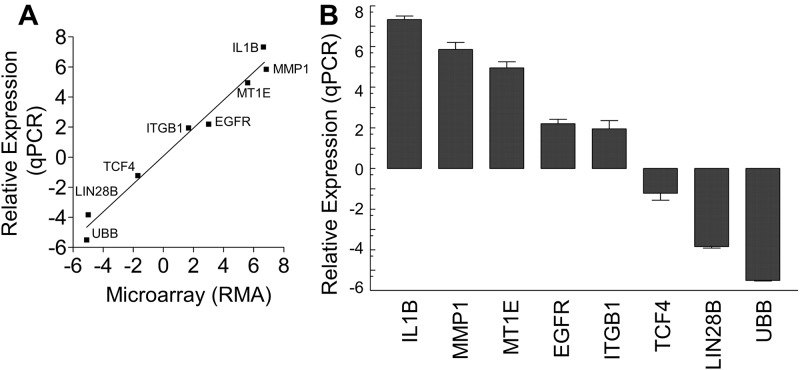
Differentially expressed transcripts between OVCAR-8R and OVCAR-8 spheroids are correlated between microarray and qPCR assays.Genes in the microarray dataset with differences in expression between sensitive and resistant ovarian cancer spheroids. (A) qPCR and microarray expression levels correlate. qPCR relative expression was calculated relative to GAPDH. Microarray scores are RMA. Trend line was determined by linear regression (r2 = 0.71, p = 0.009). (B) The fold changes for the selected transcripts.